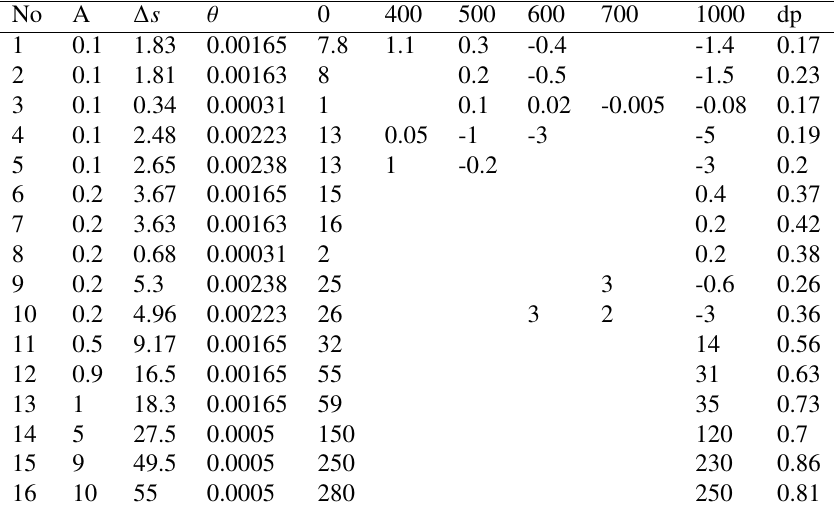
Table 2. Calculations of test model with di ff erent θ ( cm 2 / mm H g ) and contraction parameters, 0 - 1000 are values of g in cm / s 2 . There are values of time-average integral flux in the cells under values of g,